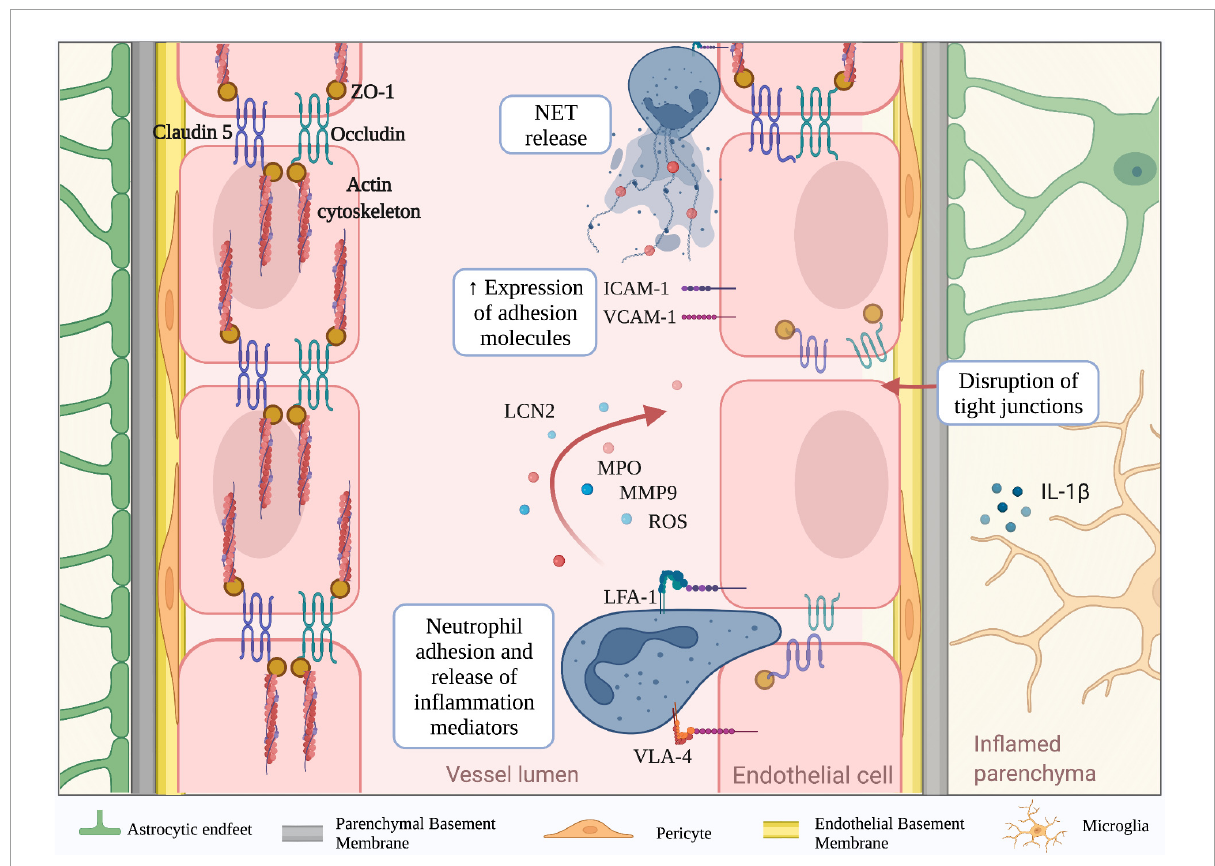
FIGURE2 Molecular mechanisms mediating neutrophil-dependent BBB dysfunction. The BBB is a complex structure mainly composed of endothelial cells tightly bound together by junctional molecules, astrocytic endfeet and pericytes. During neuroinflammation, microglia and astrocytes produce IL-1b, which is a potent inducer of endothelial ICAM-1 and VCAM-1 and promotor of neutrophil infiltration. Engagement of neutrophil integrins as well as other stimuli, lead to the production of neutrophil extracellular traps (NETs) and release of inflammatory mediators including reactive oxygen species (ROS), lipocalin 2 (LCN2), myeloperoxidase (MPO) and matrix metalloproteinase 9 (MMP-9). These neutrophil-derived factors contribute to the reduction of tight junction proteins (claudin-5, occludin and ZO-1) and BBB breakdown. (Created with